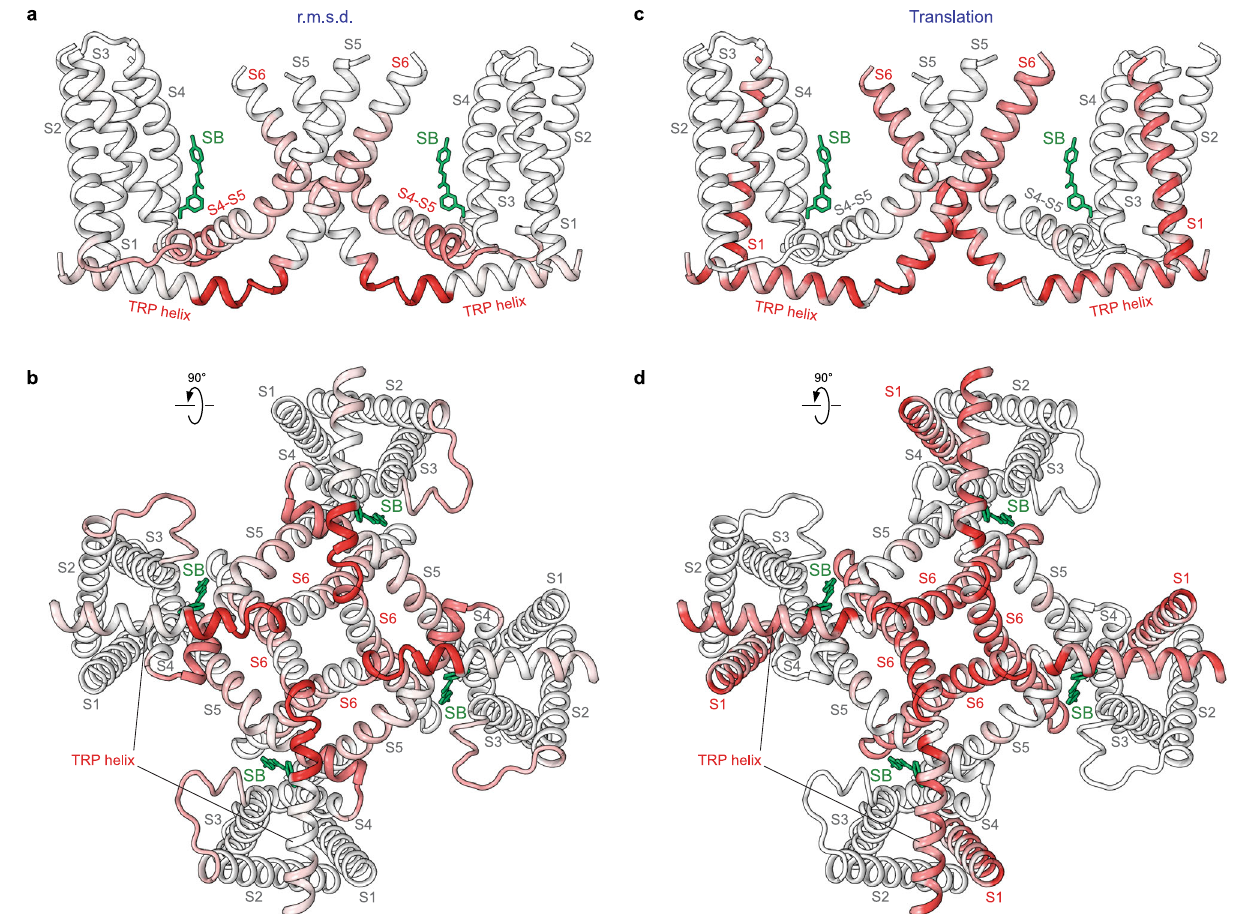
Fig. 4 |Structuralchangesaccompanying competitiveinhibitionofhTRPV1by SB-366791. a – d Gray (no changes) to red (strong changes) gradient of the r.m.s.d. ( a , b ) or translation ( c , d ) calculated between the inhibited (hTRPV1 SB-366791 ) and open(rTRPV1,PDBID:7RQW)statesandmappedonthehTRPV1 SB-366791 TMD.Only twooffoursubunitsareshownin a and c ,withthefrontandbacksubunitsomitted